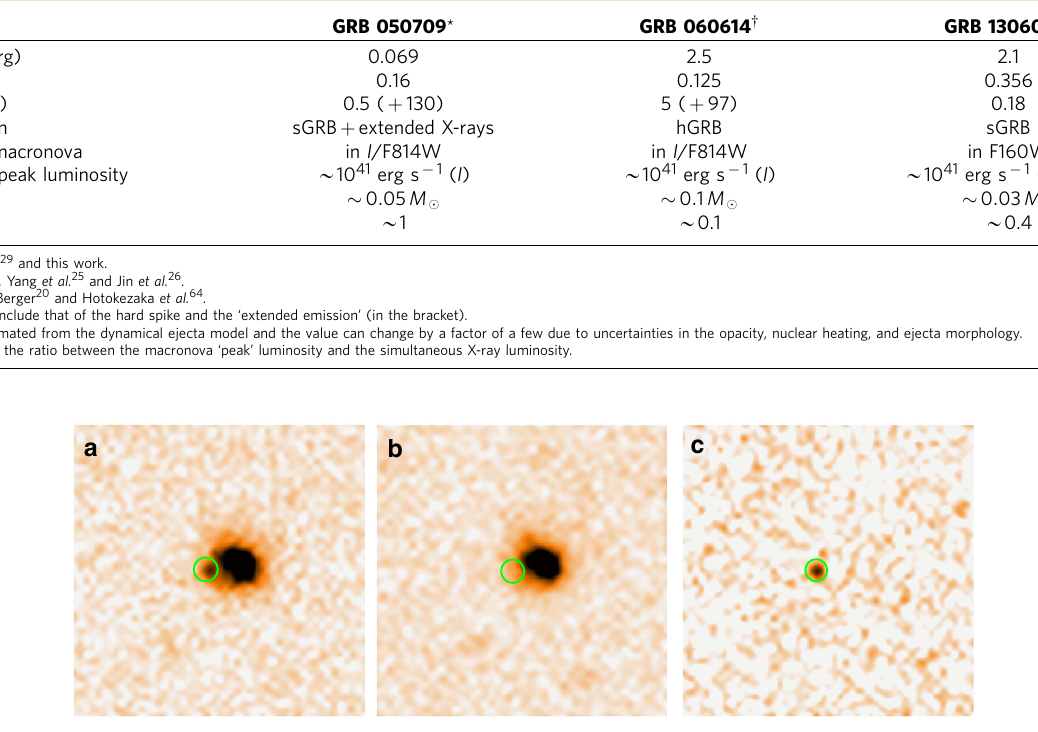
Table 1 | Physical properties of GRBs/macronovae/afterglows with known redshifts.